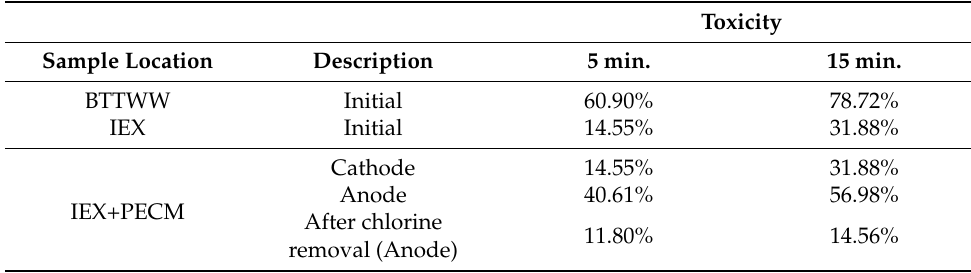
Table 4. The acute toxicity assessment of the PECM reactor.